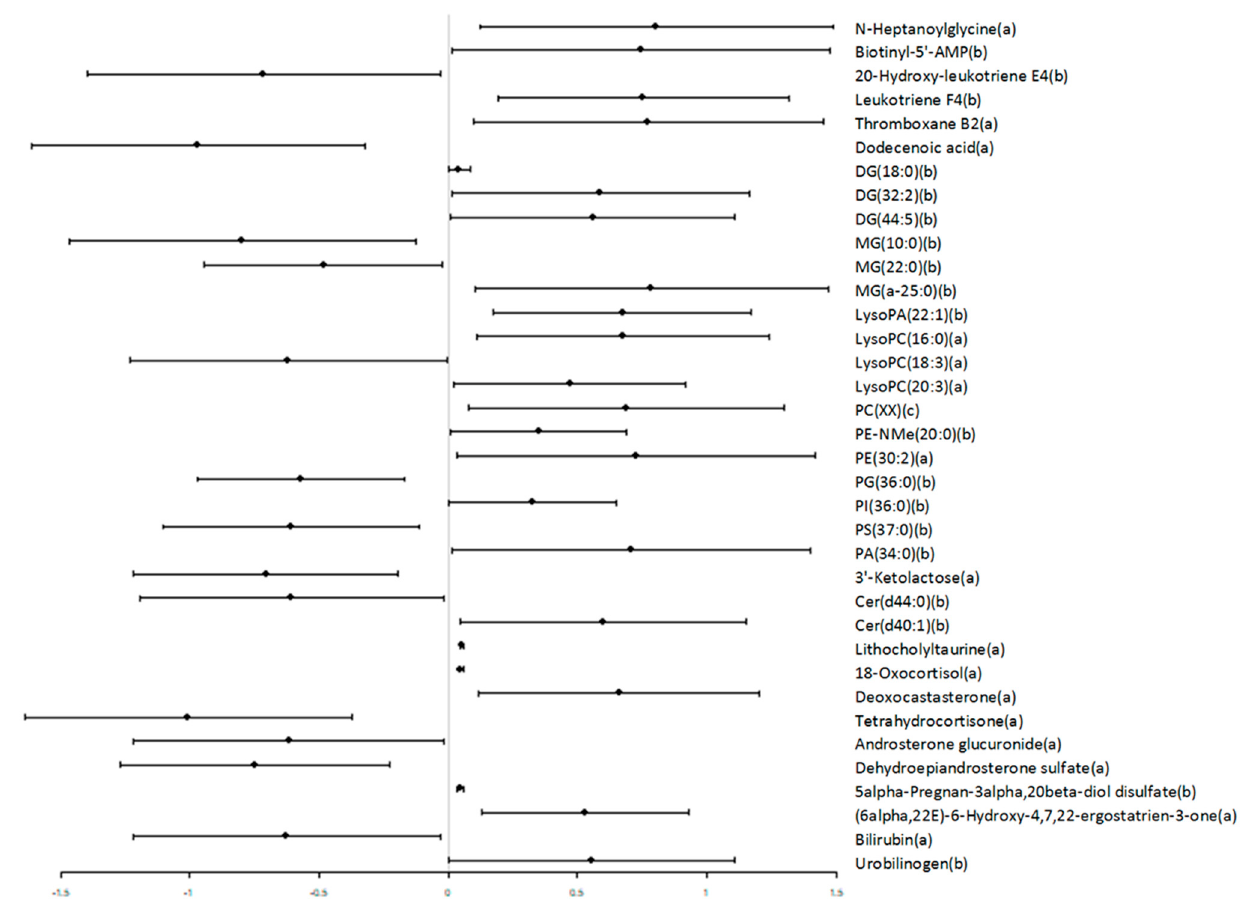
Figure 2. Lipid metabolism seems to be preferentially affected by CD. Levels of statistically significant molecules are represented using a forest plot. Forest plot dots represent the estimated difference in means, and the whiskers represent the confidence intervals. All compounds are putatively annotated based on physicochemical properties and/or spectral similarity with public/commercial spectral libraries [33]. (a) ID based on exact mass, RT, and MS/MS spectrum (high fiability); (b) ID based on exact mass and RT; and (c) ID based on MS/MS spectrum. PC(XX): the specific phosphatidylcholine species could not be annotated, but its MS/MS spectrum displayed a PC-characteristic pattern.